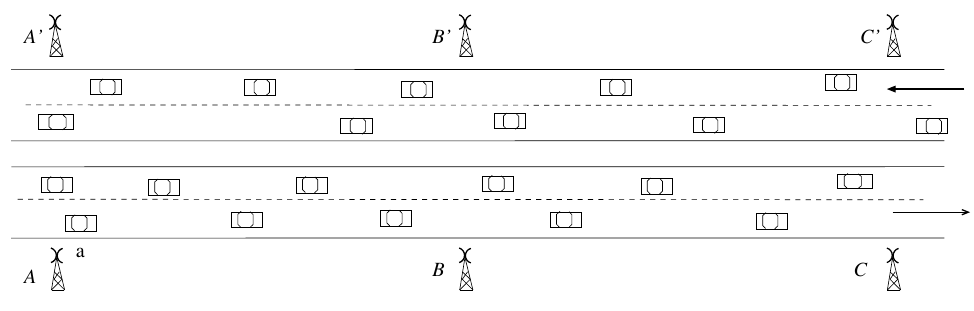
Figure 1. Illustrating a highway segment with several TMUs [85]